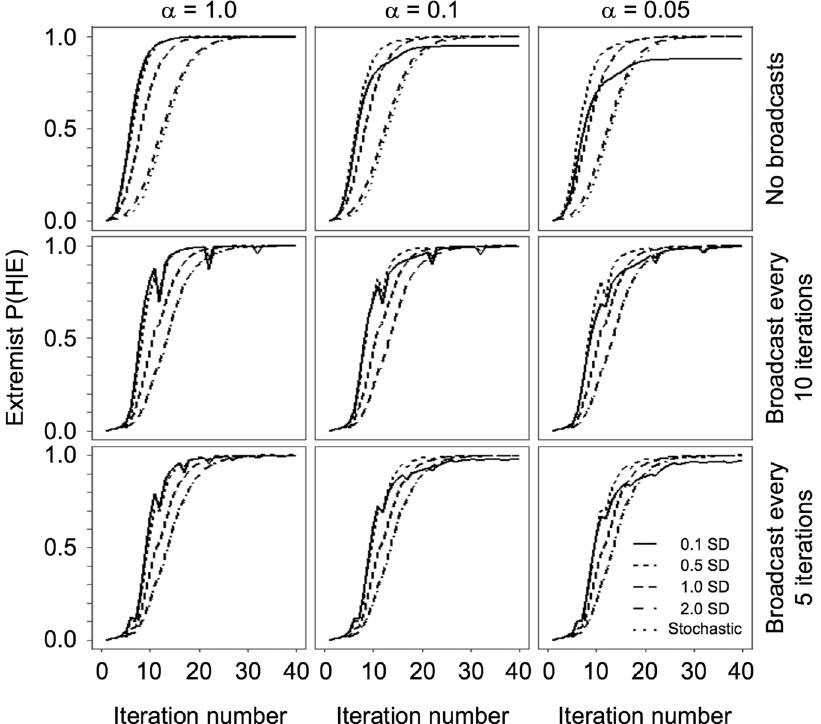
Figure 5. The evolution of confidence P(H|E) among extremist agents (defined as μ own further than 2SD from μ true ) when receiving educational interventions for nine simulations. Top row has no education (replication simulation), middle row broadcasts education every 10 ticks, bottom row broadcasts every 5 ticks. Columns depict reach in stochastic placement ( α = 1, 0.1, and 0.05). β -values range from strongly confirmatory to unused ( β = 0.1, 0.5, 1.0, 2.0, and